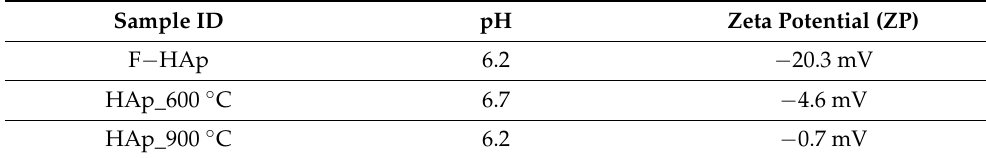
Table 4. Zeta potential measurements.